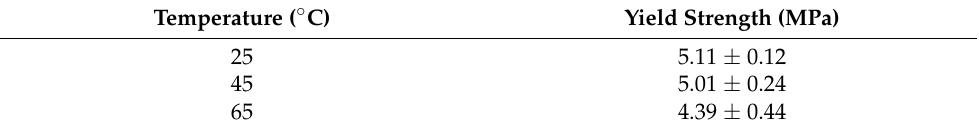
Table 2. Offset yield strength of the polyvinylidene fluoride (PVDF) membranes. Each value represents the mean calculated from measurements on three samples, and the errors represent ± 1 ơ